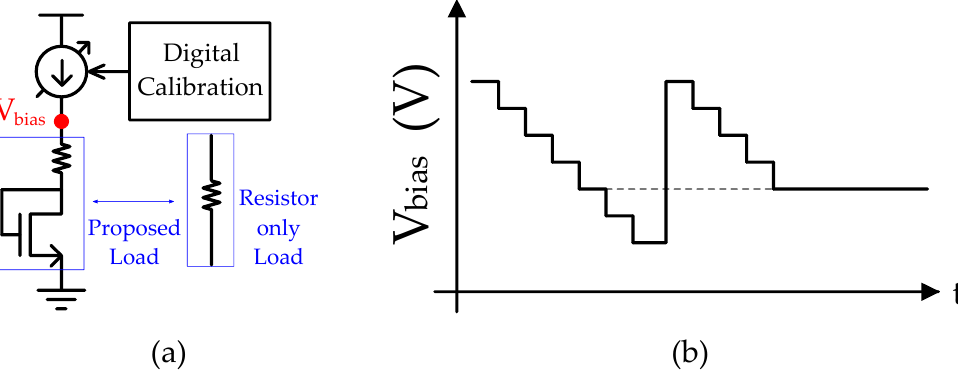
Figure 3. ( a ) Proposed bias circuit and resistor load model for comparison. ( b ) Modeling of digital calibration for Class-C VCO bias